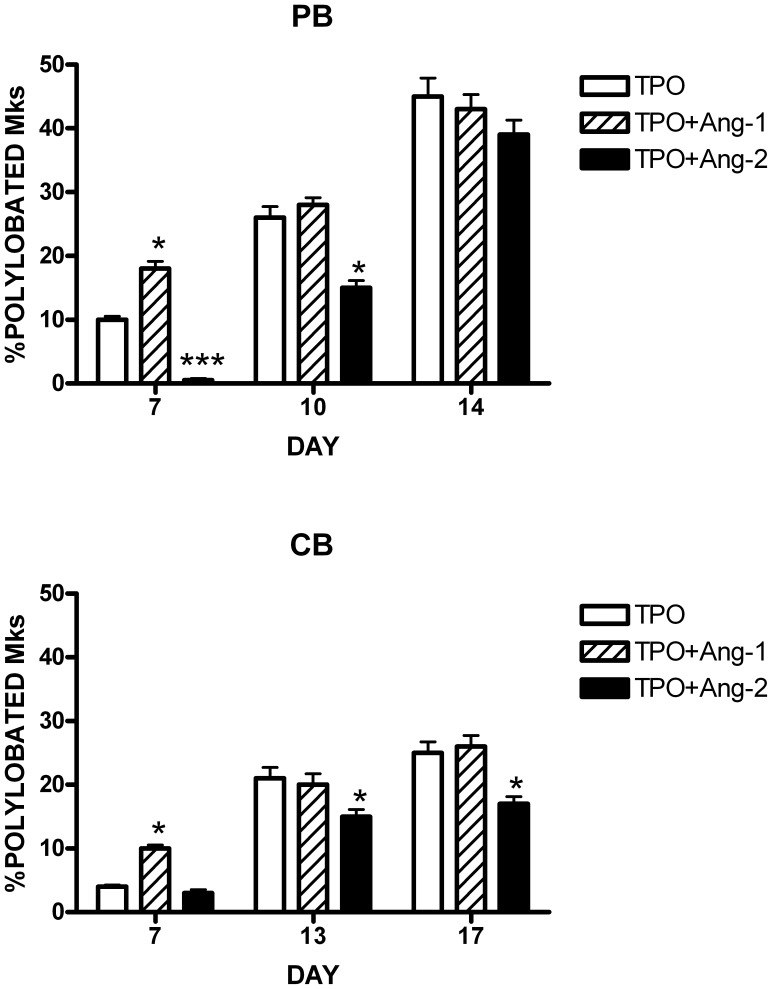
Effect of exogenous angiopoietins on TPO-driven Mk differentiation of HPCs.CD34+ HPCs purified either from CB (top panel) or PB (bottom panel) have been triggered to Mk differentiation with TPO either in the absence of growth factors (TPO ) or in the presence of either 100 ng/ml Ang-1 (TPO+Ang-1) or 100 ng/ml Ang-2 (TPO+Ang-2) and then assayed for Mk ploidy by evaluating the percentage of polylobated Mks. The data reported in the Figure represent mean values ± SEM observed in three separate experiments. * p = <0.05 when compared to the corresponding TPO-treated sample. *** p = <0.001 when compared to the corresponding TPO-treated sample.